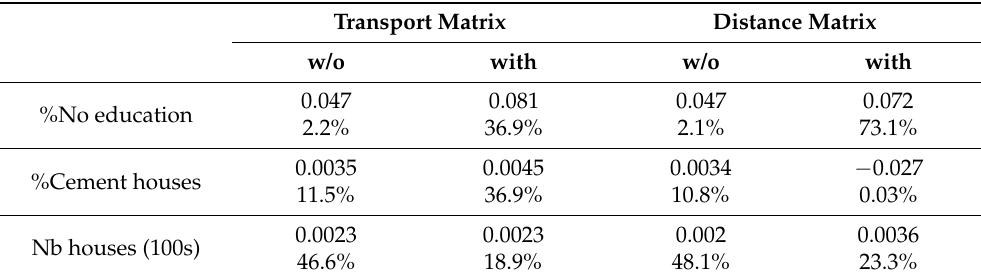
Table 5. Effect of matrices of distance and transport similarity among subdistricts and mean subdis- trict number of dengue cases on association of SE variables with residual dengue cases. Transport Matrix Distance Matrix w/o with w/o with 0.047 0.081 0.047 0.072 %No education 2.2% 36.9% 2.1% 73.1% %Cement houses